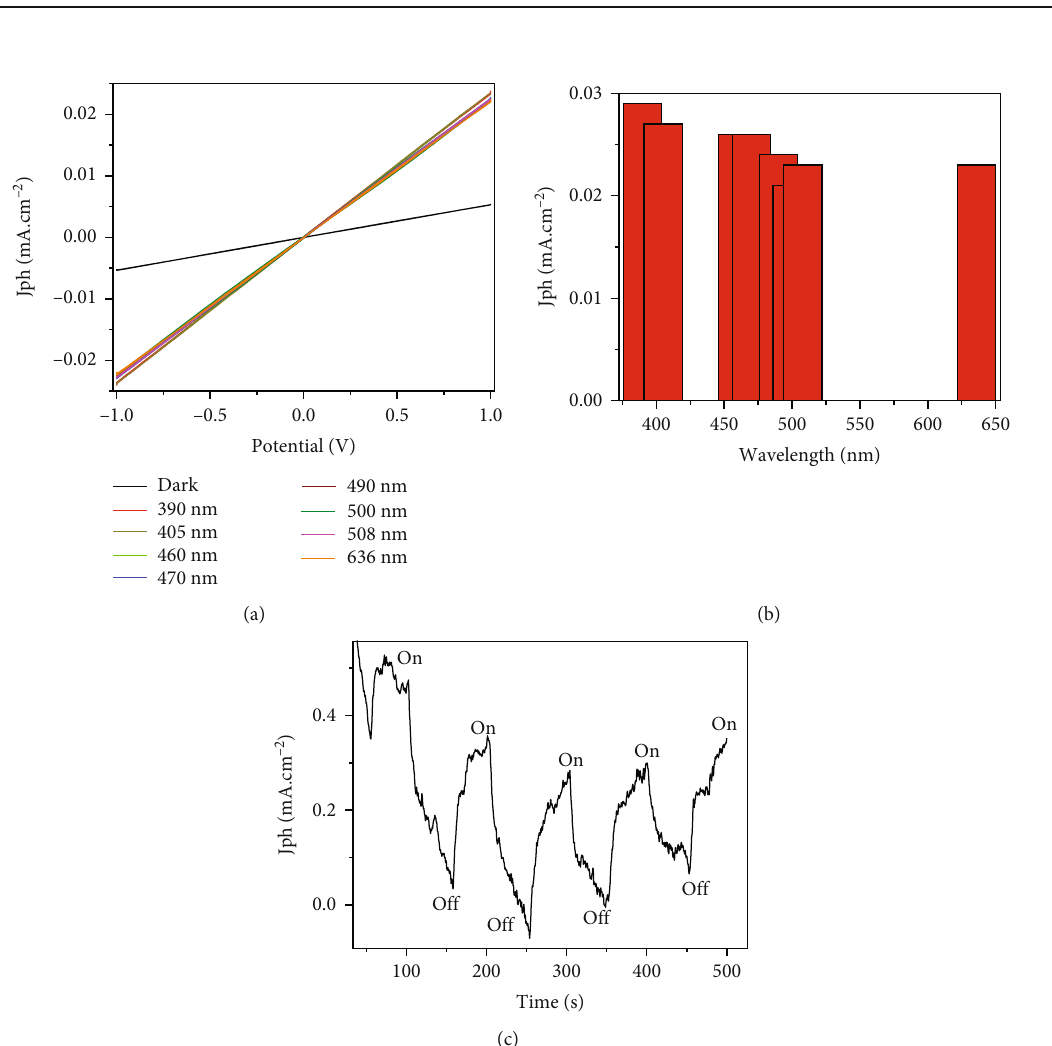
Figure 5: (a) The in fl uence of dark and light wavelengths, (b) current density at 1.0V, and (c) on/o ff chopped current for glass/P3MA/PbS photodetector at 25 °